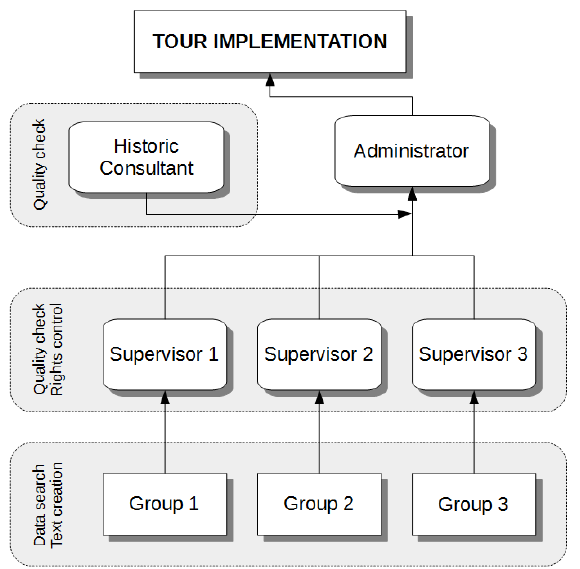
Figure 1. Hierarchy structure of the work groups